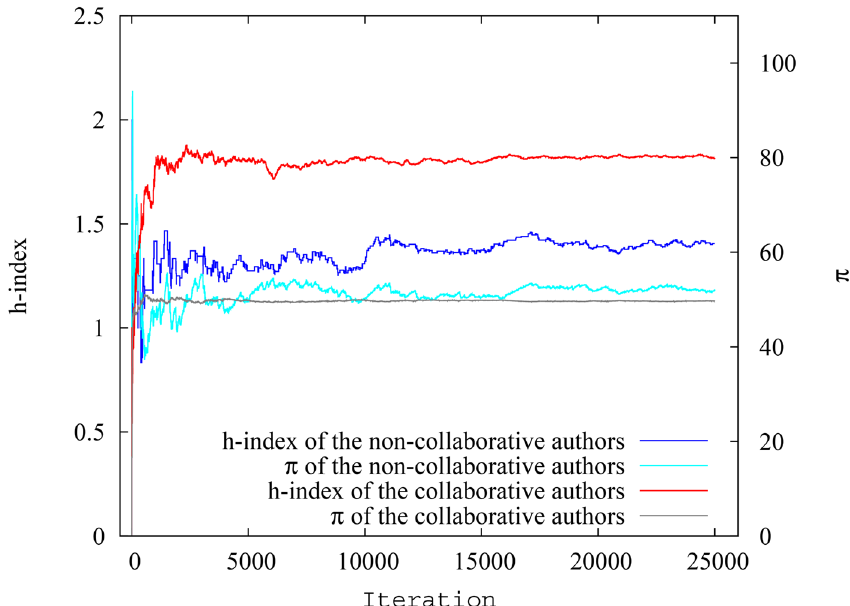
Fig 9. Variation of average h-index and pagerank-index for collaborative and non-collaborative authors at each timestep in simulation scenario 2. The difference between groups is much smaller when pagerank-index is